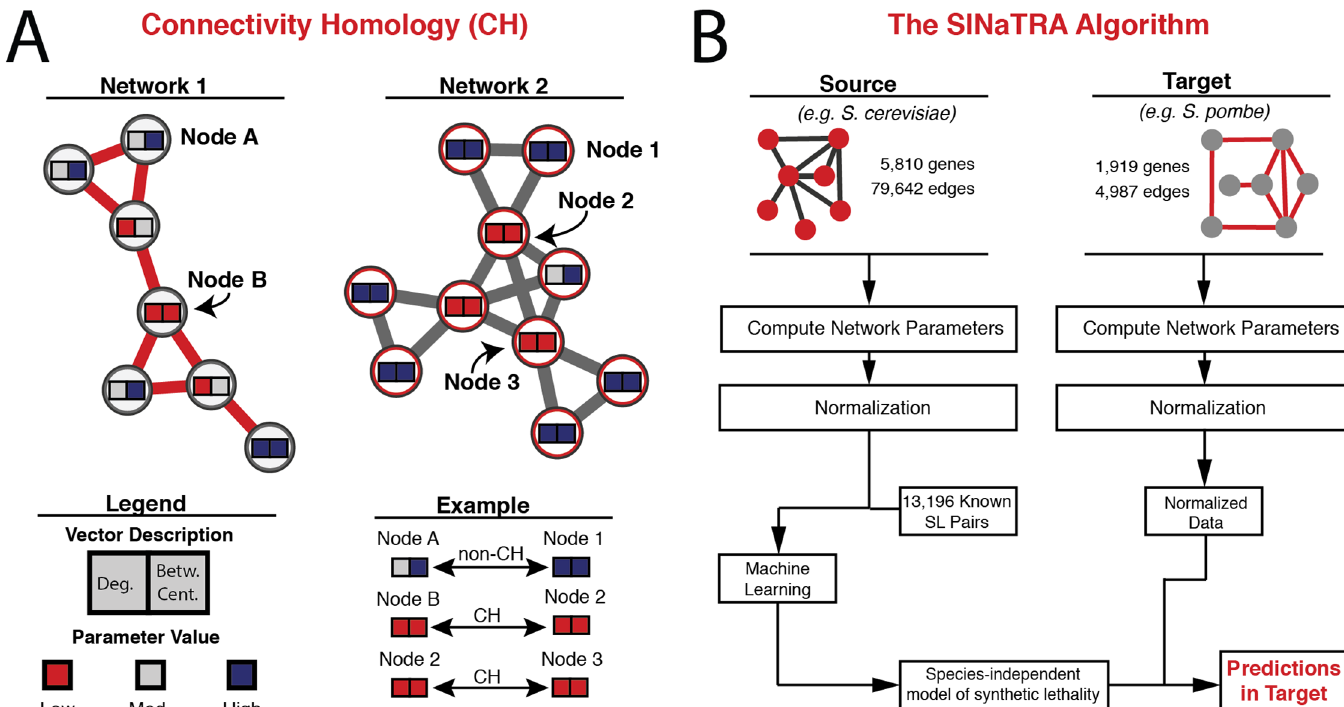
Fig 1. A) An illustration of connectivity homology (CH). Each node is described by two parameters (degree [deg.] and betweenness centrality [bet. cent.]) at three levels: low, medium, and high. Certain nodes have the same vectors (Node B/Node 2/Node 3); these nodes can be said to be connectivity homologous (CH). Other nodes do not (Node A/Node 1); these are non-connectivity homologous (non-CH). B) Schematic of the SINaTRA algorithm. We begin with the PPI networks of both our source and target species, calculate the network parameters (independently), and normalize the values of all parameters. Next, we use machine learning methods on the normalized network parameters of our source species as well as experimentally derived labels of synthetic lethality to construct a species-independent model of SL. Finally, we apply this model to the normalized network data of our target species in order to attain SL predictions in our